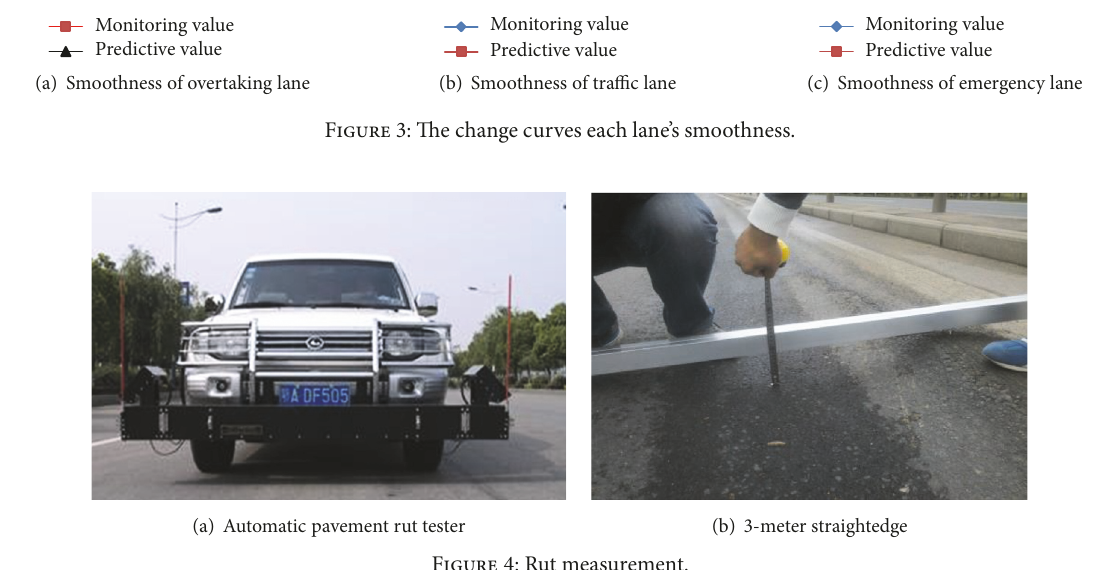
Figure 4: Rut measurement.